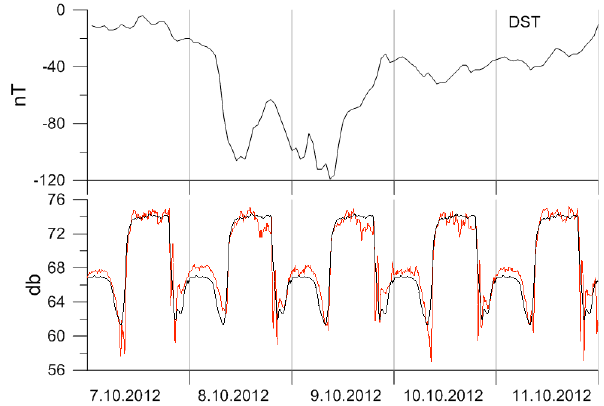
Figure 4. An example of the anomalies in the amplitude of the JJI (22.2kHz) signal during the magnetic storm on 8–9 October 2012. Red and black lines are the observed and monthly averaged signals,